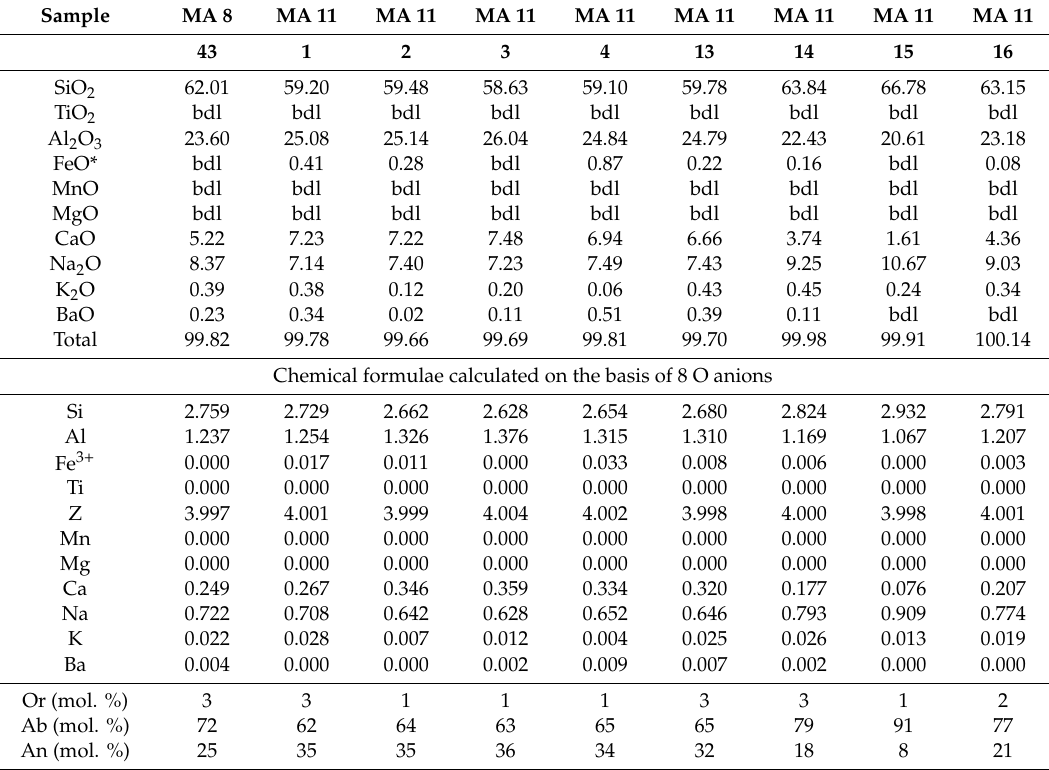
Table 6. Representative microanalyses (wt. %) and calculated formulae of hydrothermal plagioclase in sodic-calcic alteration at Maronia. FeO*: total iron as FeO; bdl: below detection